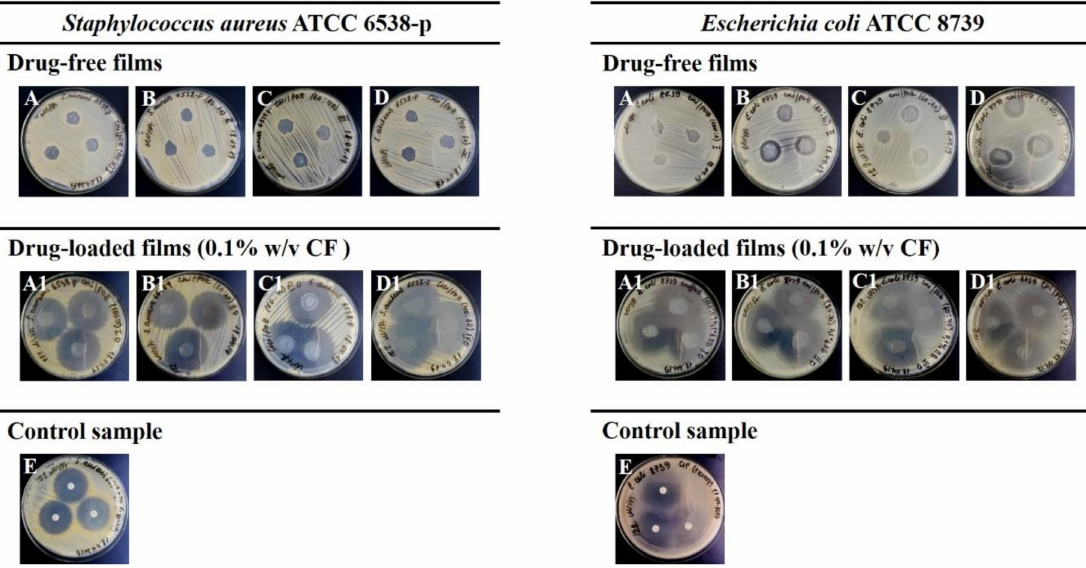
Figure 1. Inhibition zones of polymeric films against Gram-positive Staphylococcus aureus and Gram-negative Escherichia coli bacteria: A and A1— CHI (100); B and B1— CHI / POZ (80:20); C and C1— CHI / POZ (60:40); D and D1— CHI / POZ (40:60); and E—